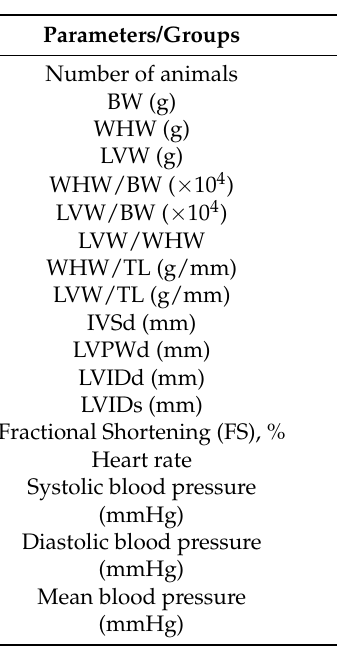
Table 1. Cardiac characteristics of the WKY, SHR, and SHR-ARB